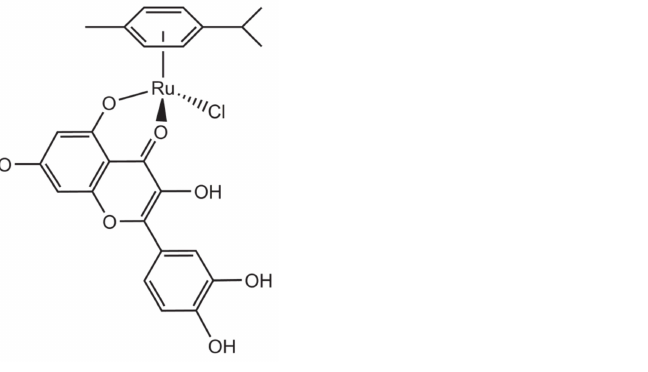
Figure 12. Structural representation of the complex [Ru( p